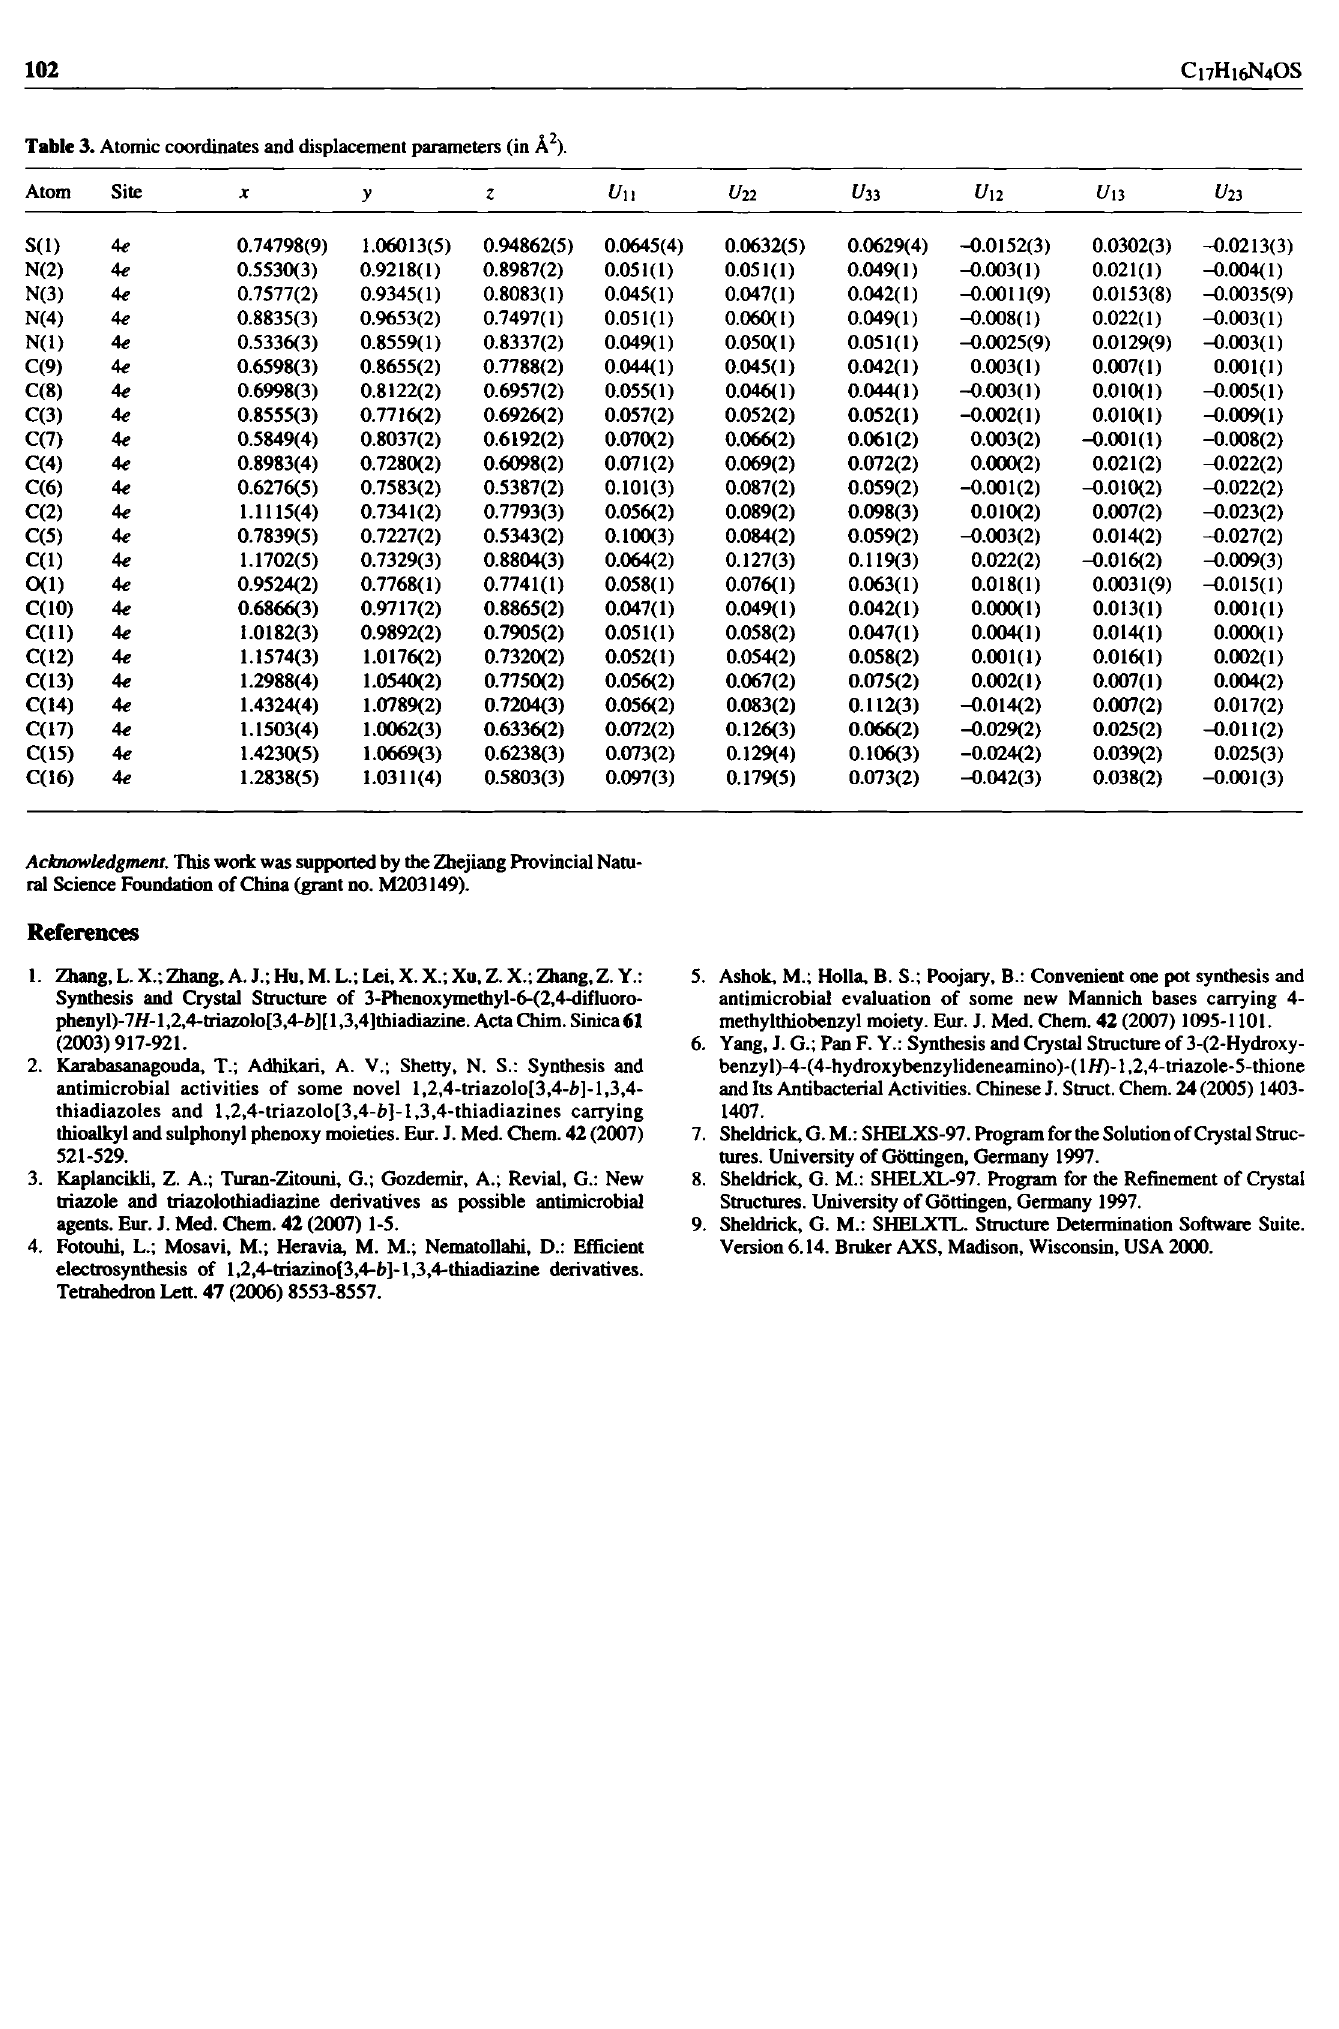
Table 3. Atomic coordinates and displacement parameters (in Â 2